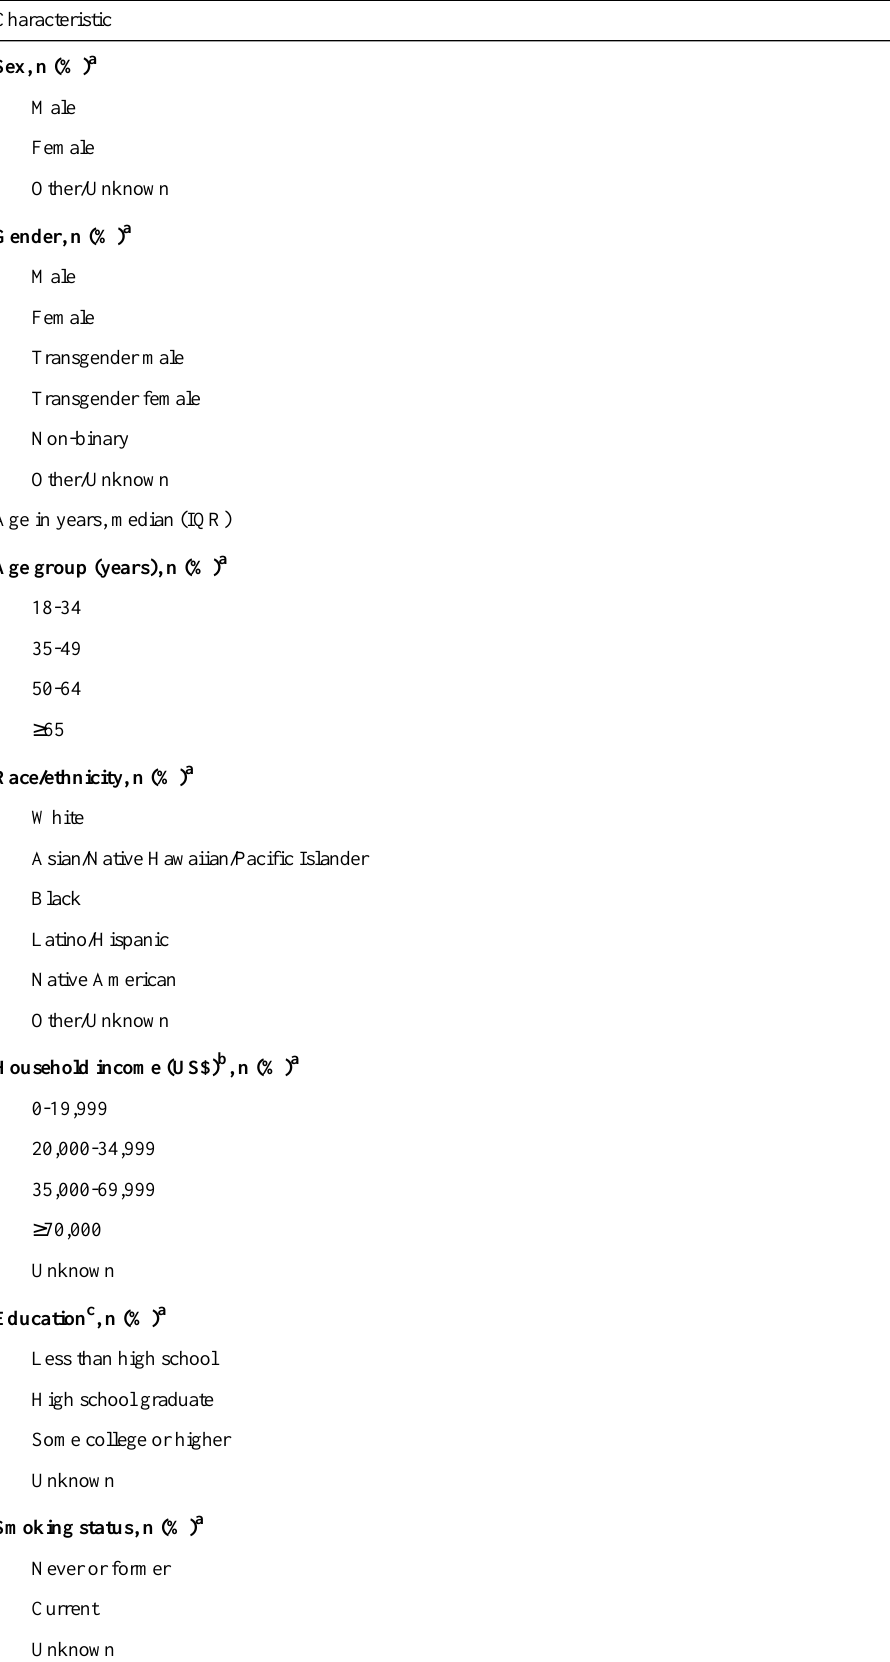
Table 2. Characteristics of patients meeting eligibility criteria for the Kaiser Permanente Northern California Adult Alcohol Registry between 6/1/2013 and 5/31/2019